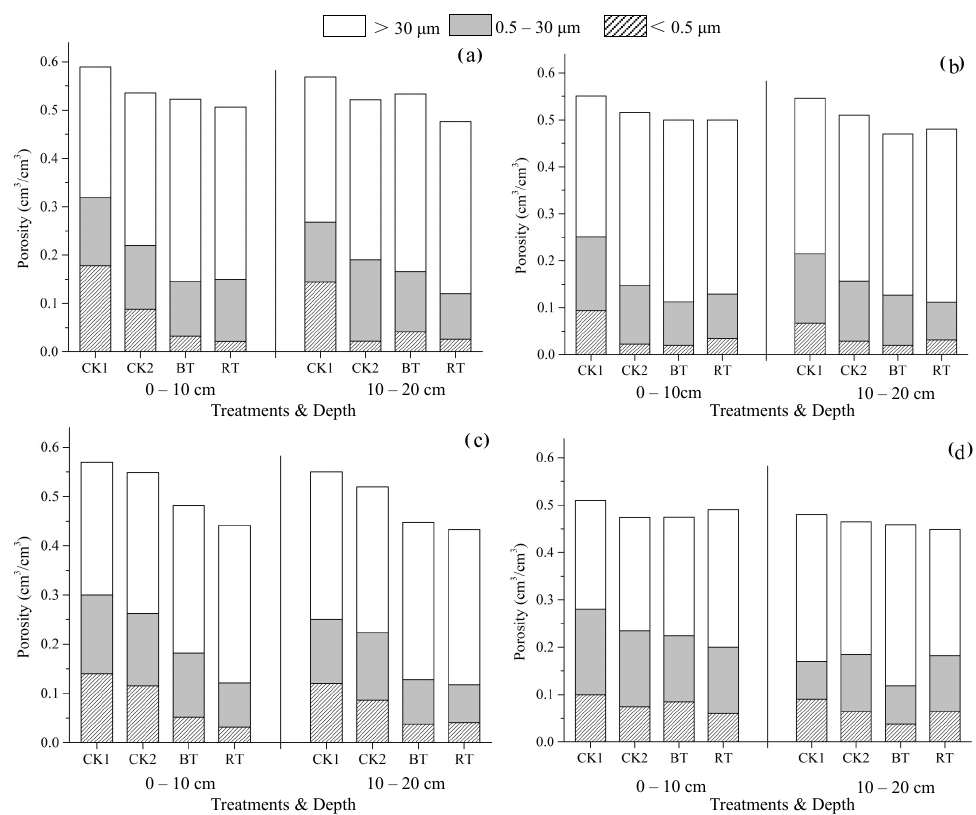
Figure 5. Soil total porosity and pore distribution at ( a ) flowering stage, ( b ) maturity stage of rape, ( c ) heading stage, and ( d ) maturity stage of rice under different tillage modes.